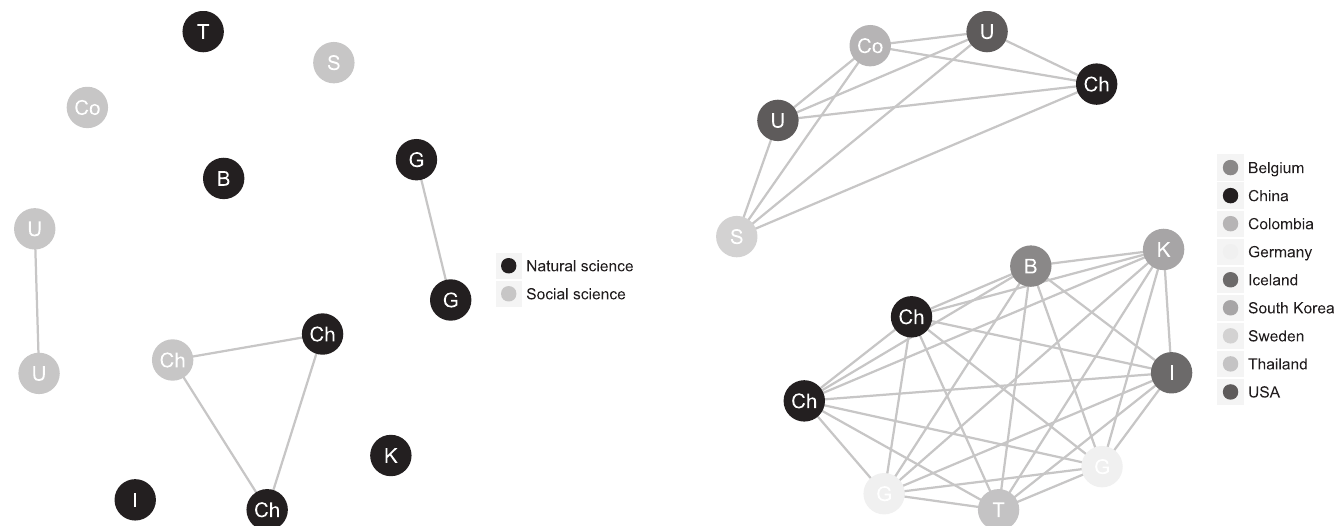
Fig 3. Example of a class from the data, with origin and choice graphs with correlation coefficient 0.059. The left panel has nodes coloured according to choice and connections between students of the same origin. The right panel has nodes coloured according to origin and connections between students making the same choice.